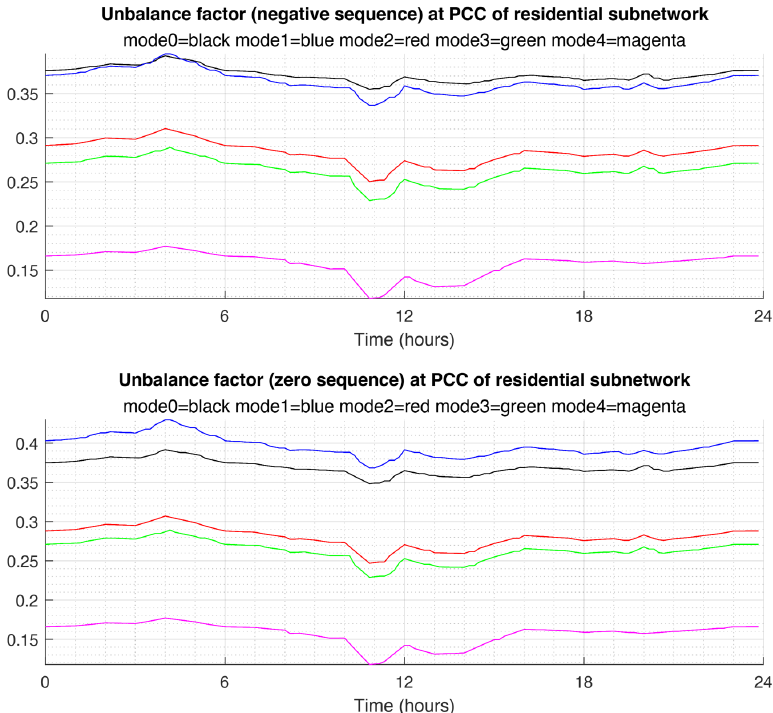
Figure 6. Effect of the control methods on the unbalance factor of the residential subgrid.